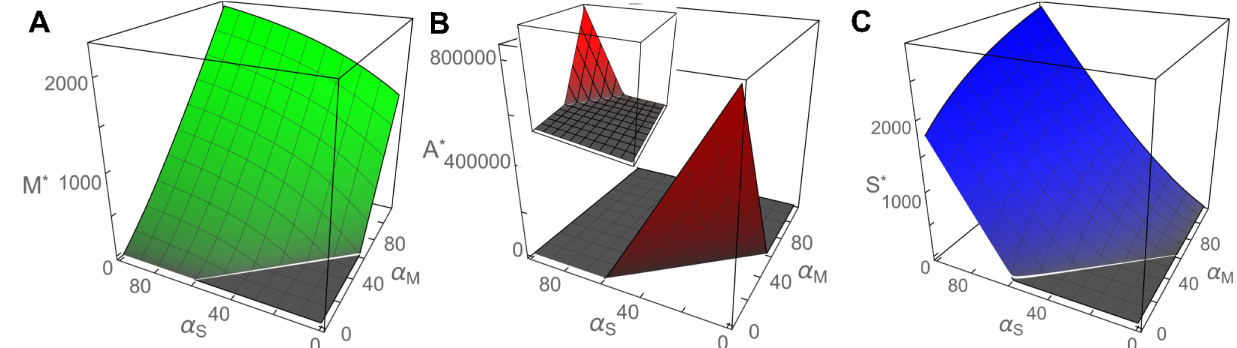
Fig 3. Approximate stationary solutions for (A) long mRNA, (B) CsrA dimers and (C) sRNA. The stationary solutionsare given as a function of the effective transcription rate α M of long mRNA and the productionrate α S of sRNA. The productionrate of CsrA dimers was set to α A = 58.52. All other system parameters are given in S1 Table. For values of α M and α S belowthe threshold, the abundances of free long mRNA and sRNA are zero, as any newly producedcomponentquickly forms a complex with the highlyabundantCsrA. At sufficiently large production or transcription rates, sRNA and long mRNA titrate all available CsrA moleculesand can thus attain non-zeromoleculenumbers, The white line gives the transition betweentwo approximate analyticalsolutions(Materials and Methods).